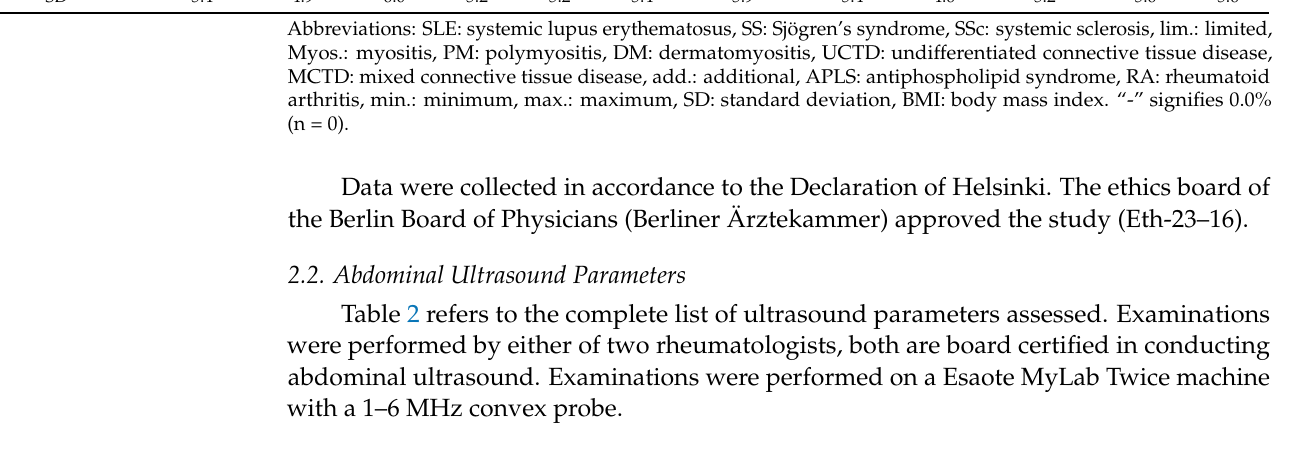
Table 2. Prevalence of abdominal ultrasound findings in systemic autoimmune rheumatic